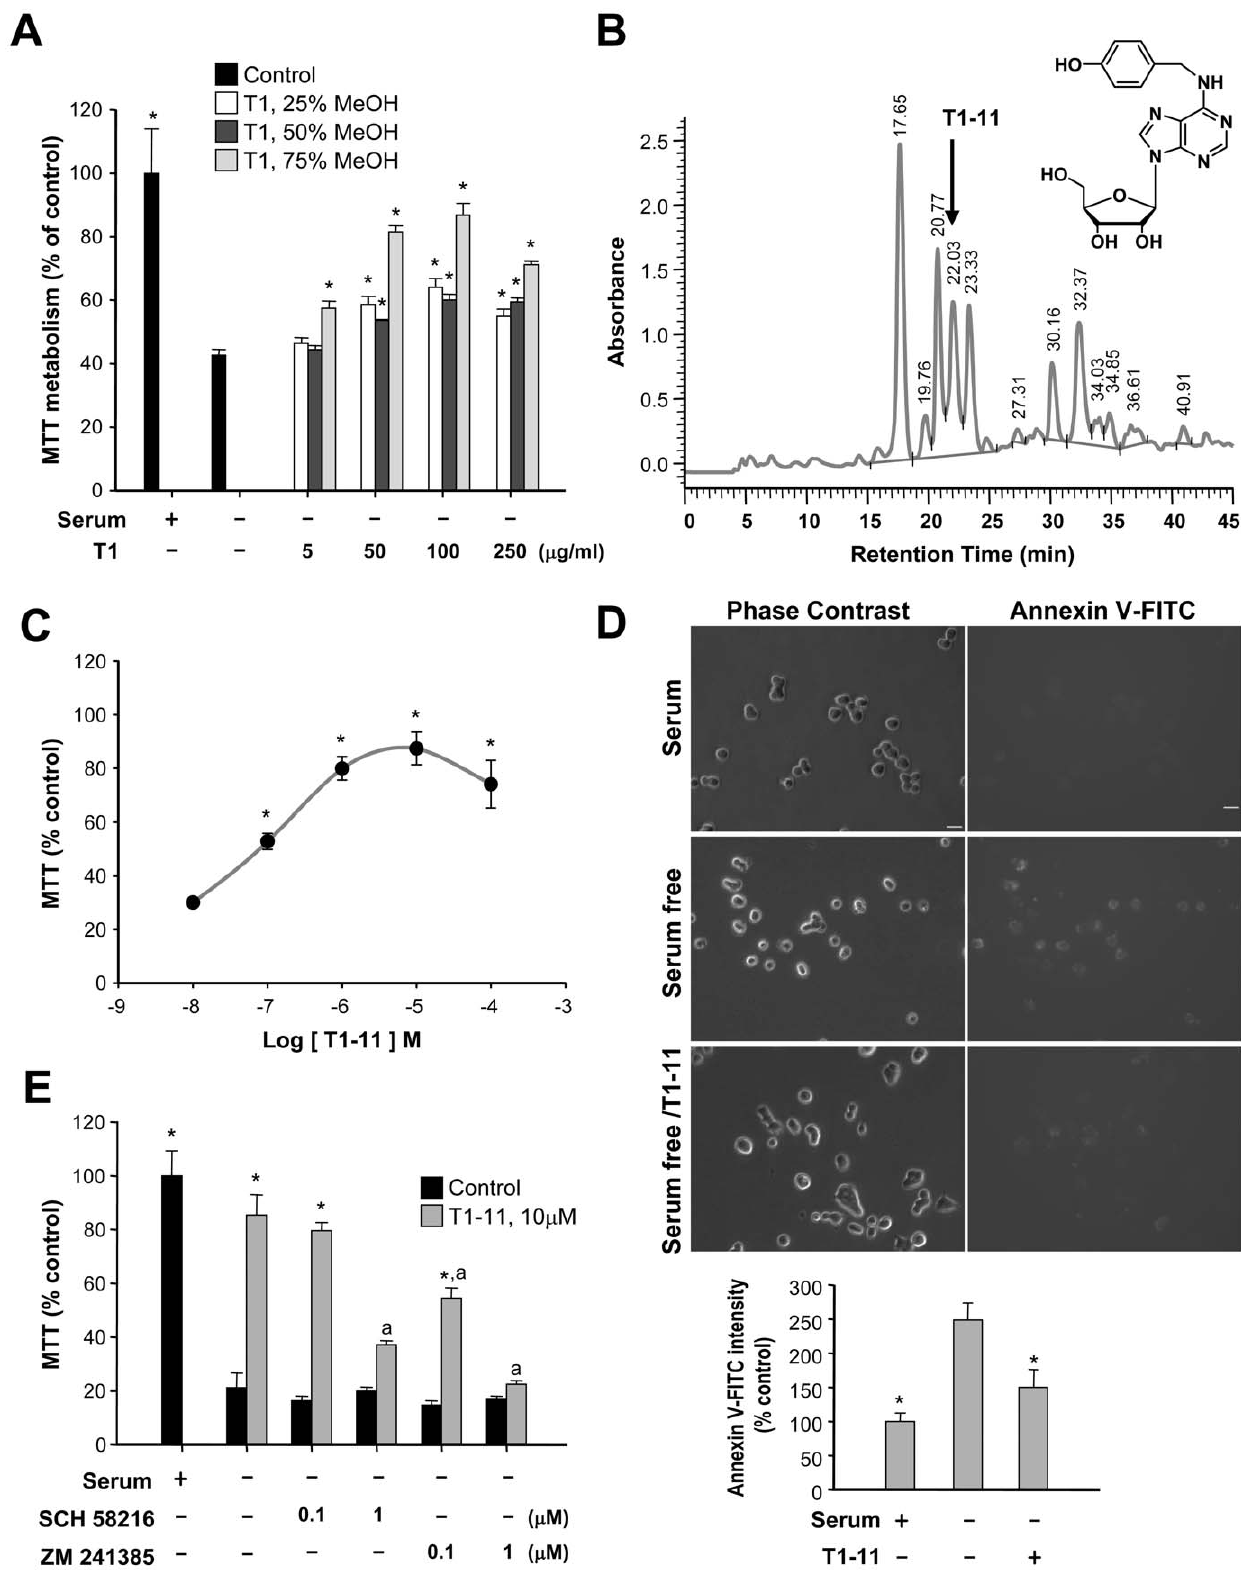
Figure 1. A fraction of the GE extract prevents serum-deprived PC12 cell apoptosis. (A, C, E) Serum-deprived PC12 cells were treated with or without the indicated reagent(s) for 24 h. Cell viability was expressed as a percentage of the MTT activity measured in the serum-containing group. Data points represent the mean 6 s.e.m. of at least three independent experiments. * p , 0.05, versus the corresponding serum-deprived group. a p , 0.05, versus the corresponding serum-deprived/T1-11 treated group. (B) Chromatogram of active fractions of GE conducted by HPLC on a Merck